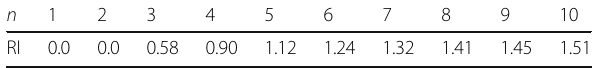
type of lithology the landslides belong to. Most of the mapped landslides have got activated in the monsoon season (July to September) in form of debris flow mostly. Some of the landslides show mudflow or earth